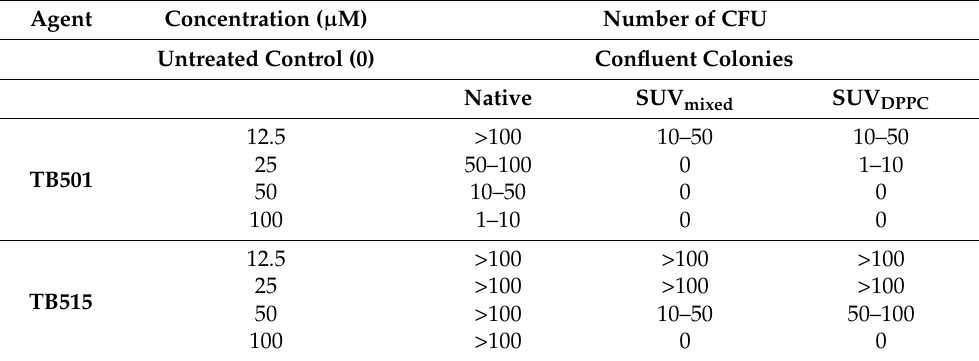
Table 4. The number of colony forming units (CFUs) on Mtb H 37 Rv infected MonoMac-6 human monocytic cell cultures after treatments with different concentrations of the two antitubercular agent candidates (TB501 and TB515) in the native environment and in the two liposome-encapsulated (SUV mixed and SUV DPPC )